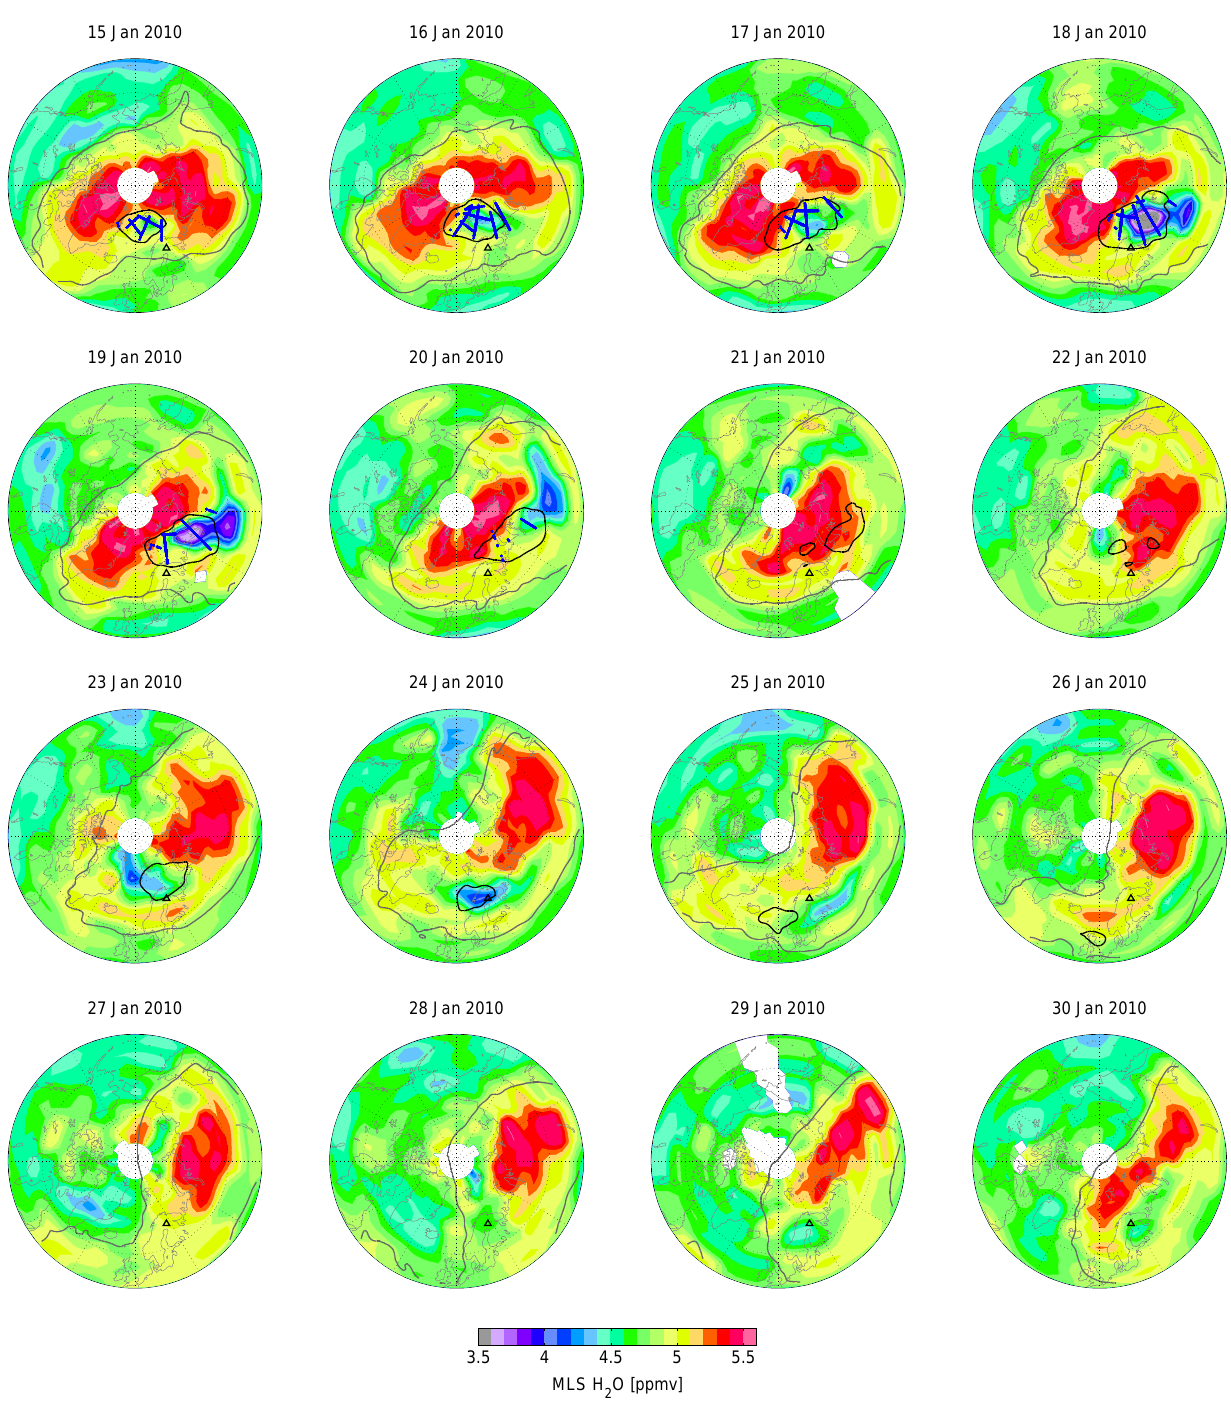
Fig. 4. Aura MLS polar projection maps of water vapour mixing ratio for 15–30 January 2010, interpolated onto the 490K potential temper- ature surface. Grey contour denotes the vortex boundary given as the potential vorticity value of 35 × 10 − 6 Km 2 kg − 1 s − 1 Black contour: 187K at 00:00UTC T frost at 30hPa, assuming 5ppmv of water vapour). Blue markers: CALIOP observations of ice clouds thicker than 540m in the 20–24km altitude range. Balloon sounding location is marked with a black